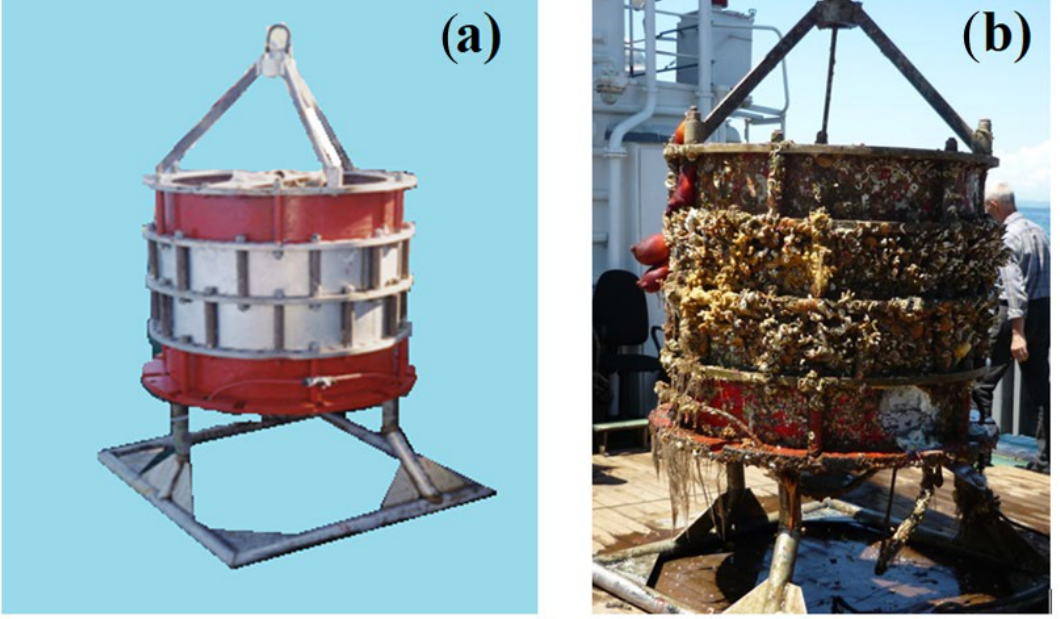
Figure 1. Stationary broadband hydroacoustic source: ( a )—appearance, ( b )—after 12 years of oper- ation at a stationary position at sea.